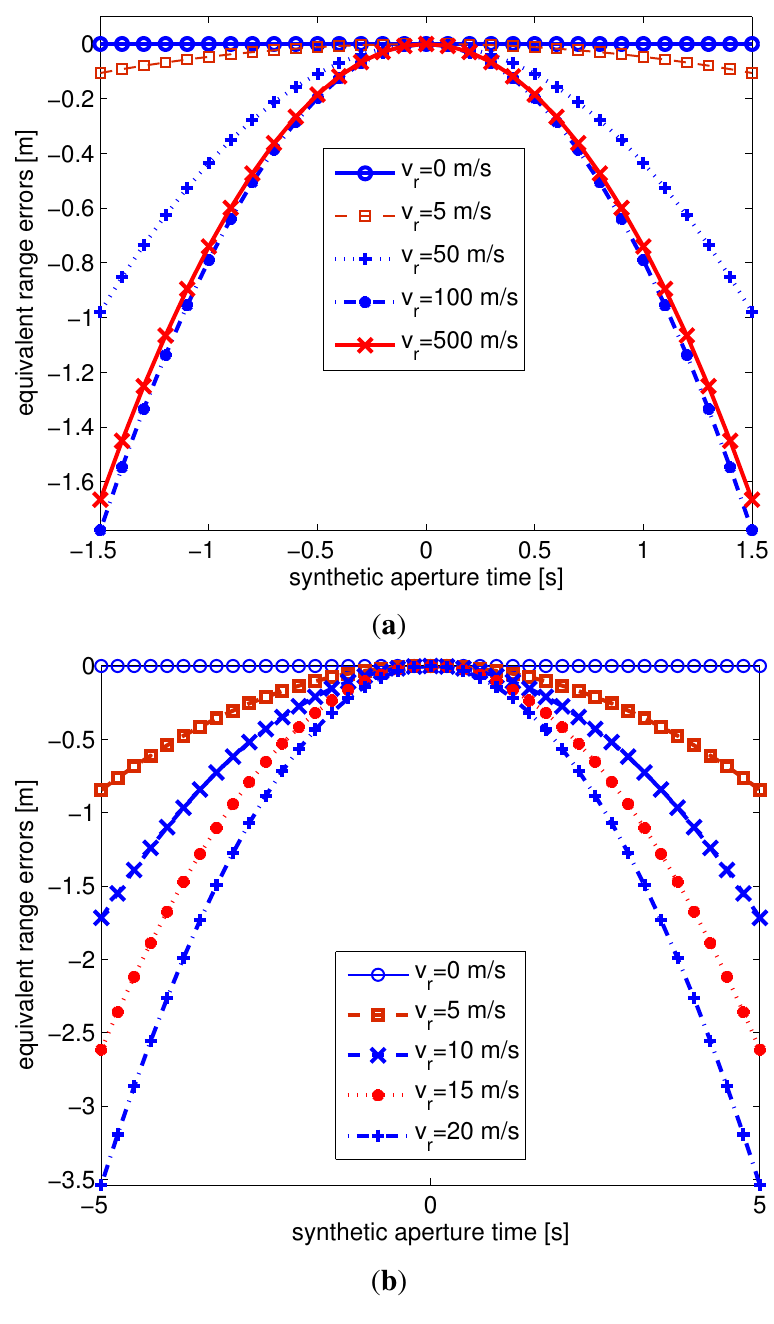
Figure 6. Range errors caused by the equivalent BiSAR geometry model. ( a ) Spaceborne = 800 km, v = 7 , 600 m/s); ( b ) Airborne transmitter ( R transmitter ( R t 0 t v = 100 t